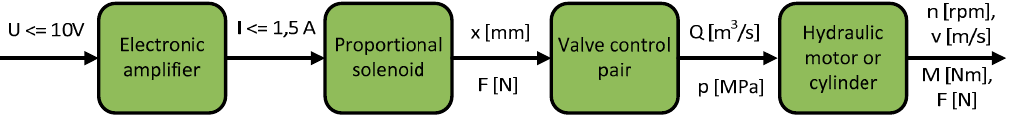
Figure 1. Schematic diagram of the control signal in the proportional control technique.